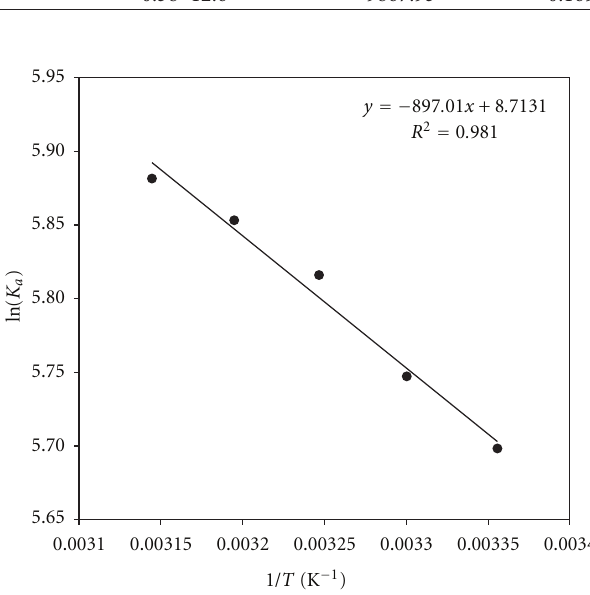
F 5: Plot of energy of activation of 2, 4-D